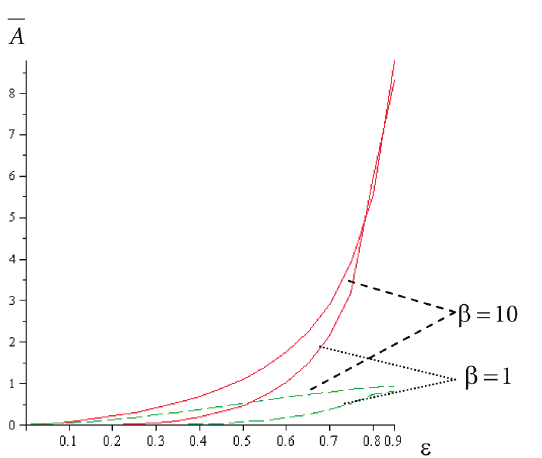
Fig. 2. The relative amplitude of the resonant mode versus the parameter e = R 1 /R 0 , at t 0 = R 0 /c and v = l 1 for isotropic ( b = 1 and ν = 0.3) and anisotropic ( b = 10) spheres in a light liquid ( 400 g = ). Dashed lines indicate variations in the stationary amplitude according to the quasi-static